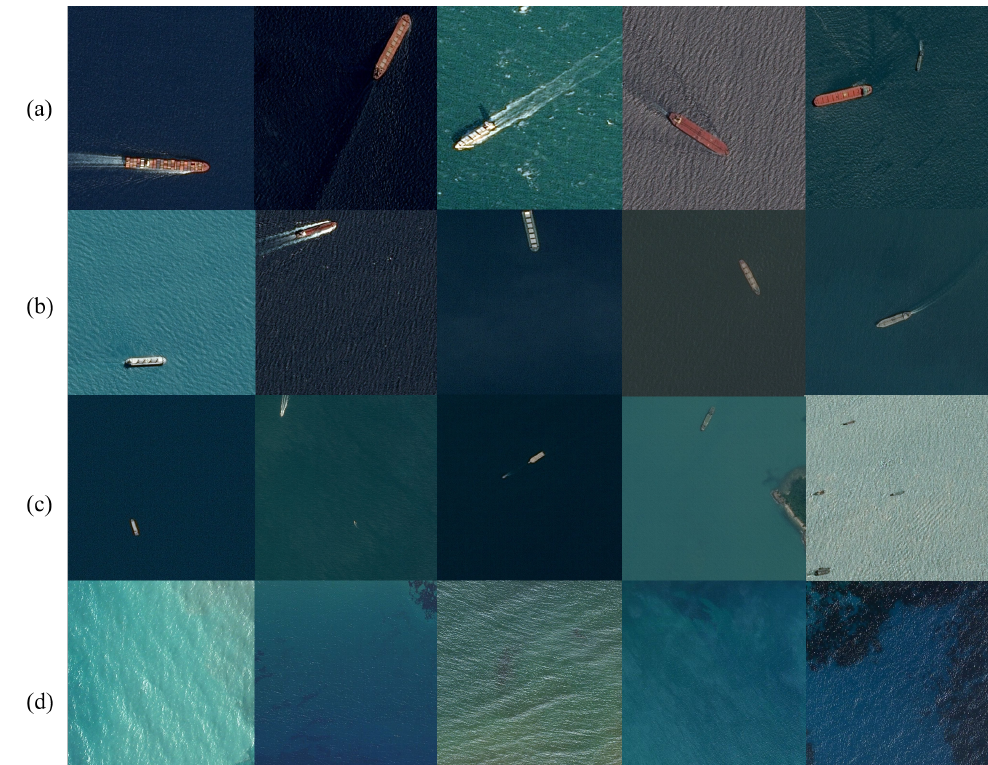
Figure 4. Illustration of the Airbus dataset. The captured ships take up various sizes in the image area, with ( a ) large ships occupying areas more than 96 × 96 pixels, ( b ) medium-sized ships occupy areas between that of the large and small ships, ( c ) and small ships occupy areas less than 32 × 32 pixels; ( d ) images of marine surface with no